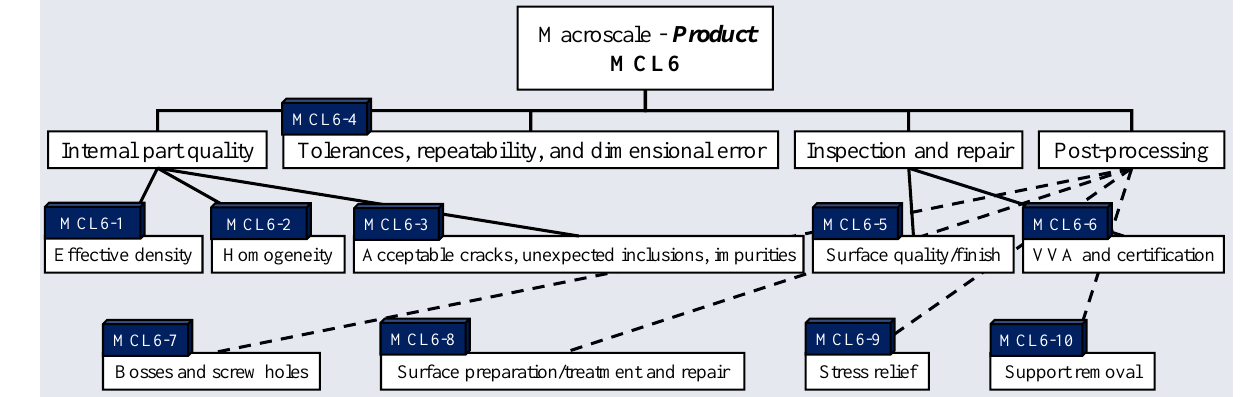
Figure 12. Essential manufacturing constraints at the macroscale (product)